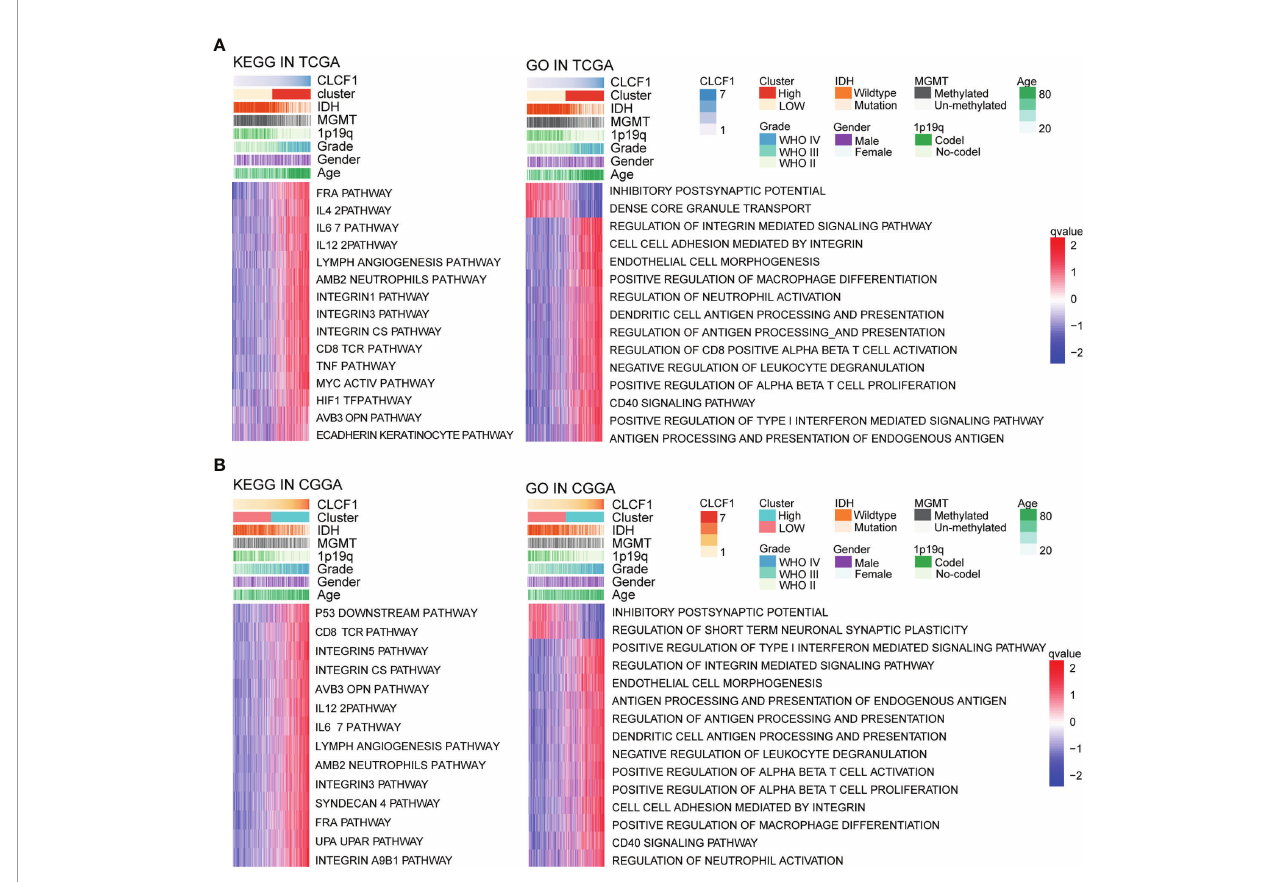
FIGURE 5 | KEGG and Gene Ontology analysis for CLCF1 in pan-glioma based on (A) TCGA and (B) CGGA